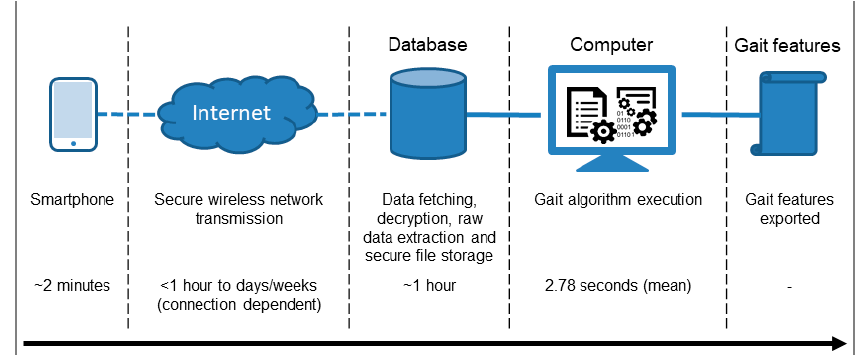
Figure 3. Data flow and approximate timeline which includes performing the 2MWT, wireless transmission of inertial monitoring unit (IMU) data, database processing and file extraction, gait algorithm execution and gait feature export.